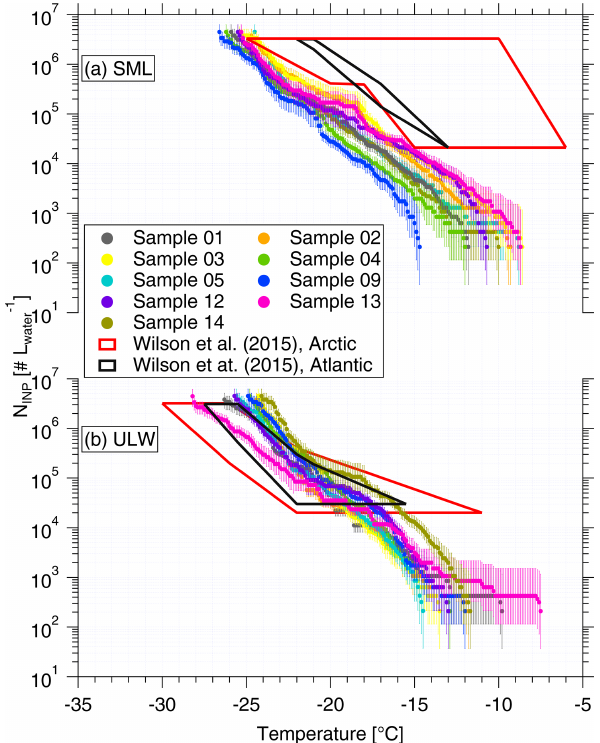
Figure 1. N INP as a function of temperature in SML (a) and ULW (b) . Error bars show the 95% confidence interval. Previous field measurements of N INP in seawater by Wilson et al. (2015) are compared, as shown by red and black